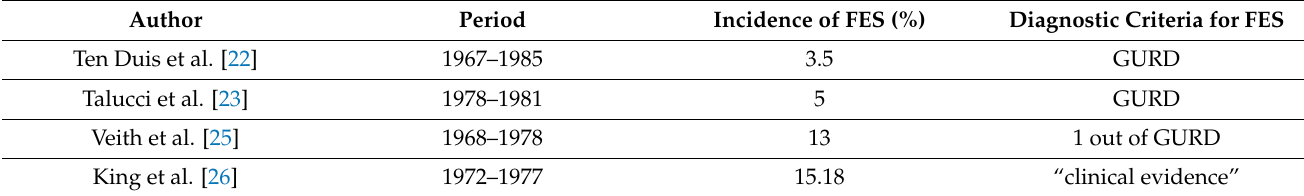
Table 3. Diagnostic tools/criteria applied to diagnose fat embolism syndrome